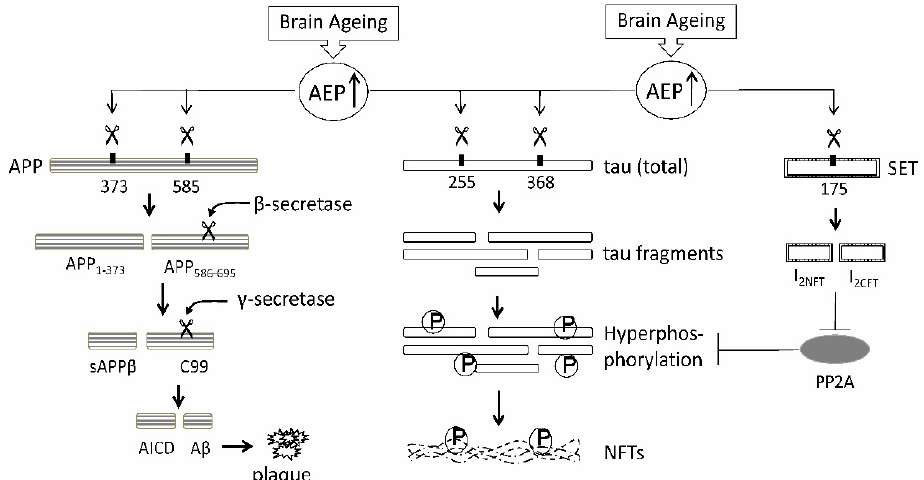
Figure 1. The pathogenic pathways of Alzheimer’s disease (AD) triggered by the asparaginyl endopeptidase (AEP). With brain aging, expression and activity of AEPs are upregulated. Overactivated AEPs cleave amyloid precursor proteins (APPs) at N373 and N585 residues. The cleavage of APPs at N585 removes steric hindrance between β-secretase enzymes and APPs, facilitating β-secretase to process APP586-695, subsequently leading γ-secretase to generating more Aβ. Concurrently, AEPs hydrolyze tau protein at N255 and N368 sites, generating neurotoxic fragments that elicit the hyperphosphorylation of tau and the formation of neurofibrillary tangles (NFTs). AEPs also digest SET, the inhibitor 2 (I 2PP2A ) of protein phosphatase 2A (PP2A), at Asn-175 into the N- and the C-terminal fragments (I 2NTF and I 2CTF ). Both I 2NTF and I 2CTF bind to the catalytic domain of PP2A; this binding represses the phosphatase activity of PP2A and promotes the hyperphosphorylation of tau. AEP ↑ : up-regulation of AEPs; ○ P : phosphorylation of tau.